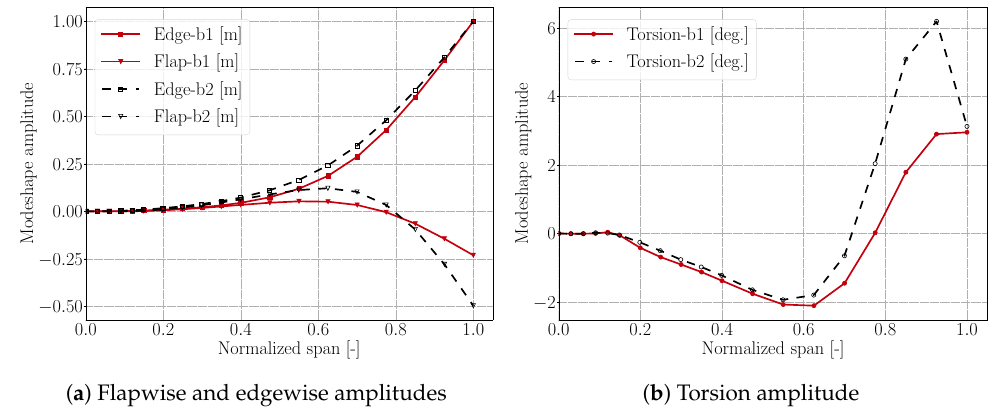
Figure 11. Second mode shape flapwise and edgewise shown in ( a ), and torsion amplitudes shown in ( b ) for both blade designs at the operation point with the 10m/s wind speed. See Figure 8 for comparison. (Blade-1: b1, Blade-2: b2) (aeroelastic